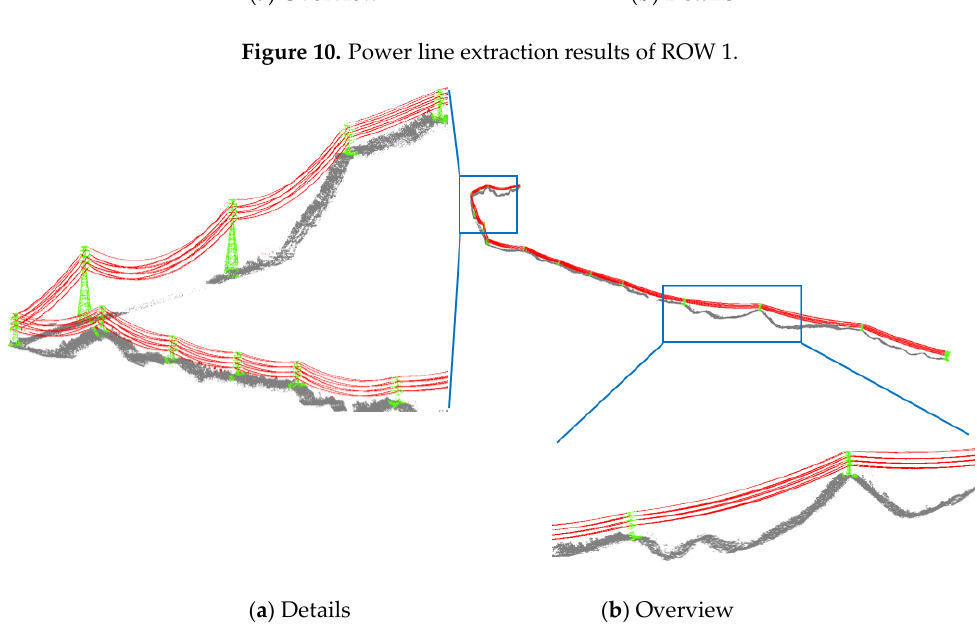
Figure 11. Power line extraction results of ROW 2.